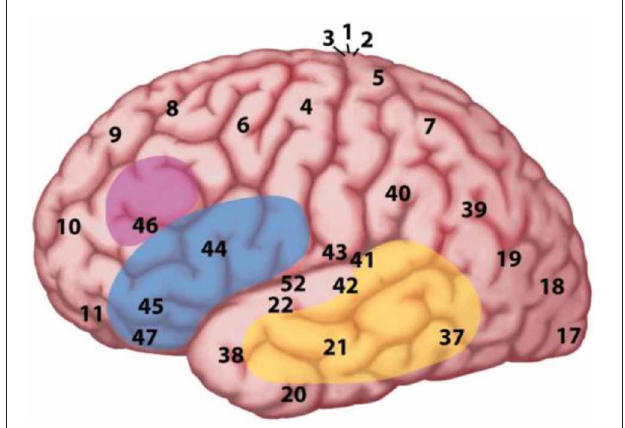
FIGURE 1 | The classical Wernicke-Lichtheim-Geschwindmodel of the neurobiology of language. In this model Broca’s area is crucial for language production, Wernicke’s area subserves language comprehension, and the necessary information exchange between these areas (such as in reading aloud) is done via the arcuate fasciculus, a major fiber bundle connecting the language areas in temporal cortex (Wernicke’s area) and frontal cortex (Broca’s area). The language areas are bordering one of the major fissures in the brain, the so-called Sylvian fissure. Collectively, this part of the brain is often referred to as perisylvian cortex.